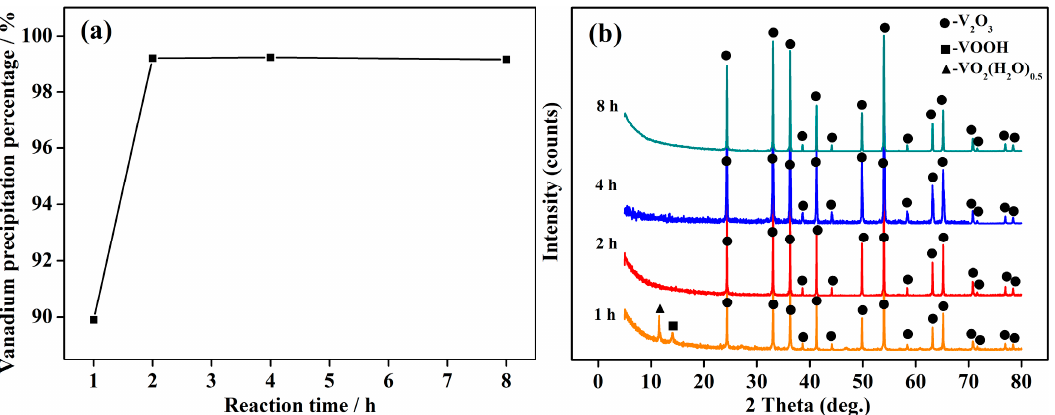
Figure 6. ( a ) Effect of reaction time on the vanadium precipitation percentage; ( b ) XRD patterns of the precipitates obtained at different reaction time.